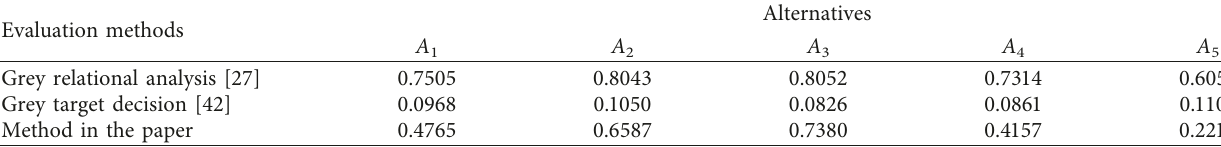
Table 6: The results of different methods.